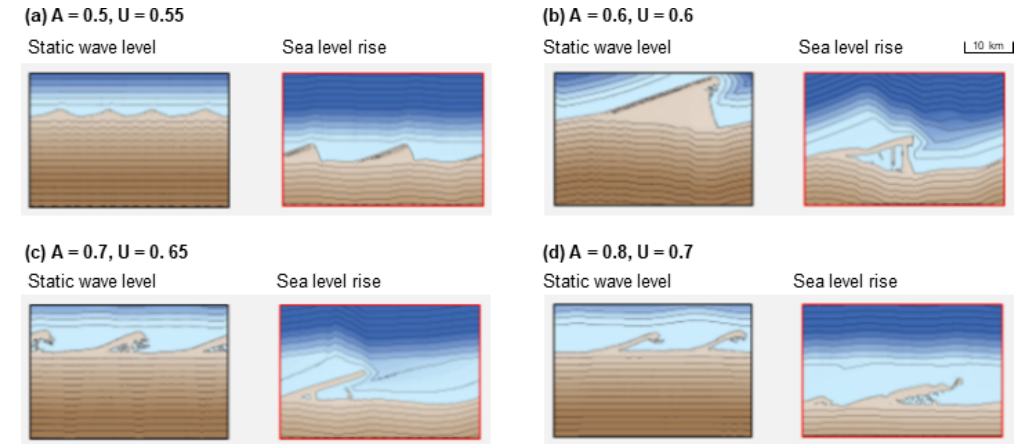
Figure 18. Coastal morphologies for four simulations where the wave climate is defined by (a) A = 0.5 and U = 0.55, (b) A = 0.6 and U = 0.6, (c) A = 0.7 and U = 0.65, and (d) A = 0.8 and U = 0.7, run with two water level scenarios including a static water level (left, black outline) and a rising sea level at a rate of 2m/100yr (right, red